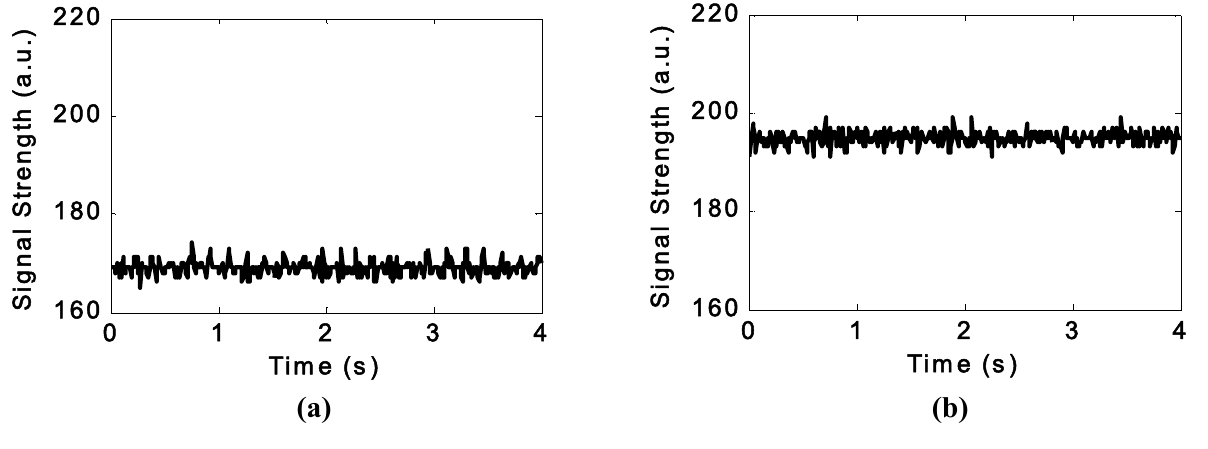
Figure 8. The response of the force transducer (a) as the pipe is being lowered into the trench and (b) after the backfill was